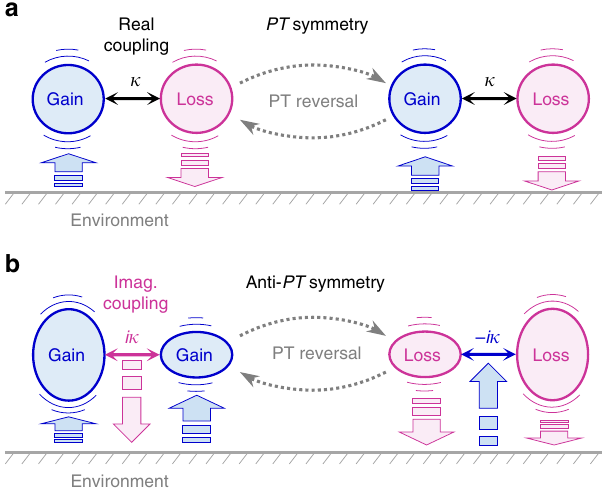
Fig. 1 Schematic diagrams of parity-time and anti-PT symmetric binary systems. a Parity-time (PT)-symmetric coupled oscillators implied by the PT-symmetric Hamiltonian H (PT) in Eq. (1). b Anti-PT (APT)-symmetric binary system derived from the relation H (APT) = ± iH (PT) . In the two diagrams, κ denotes inter-resonator coupling constant and vertical arrows indicate directions of energy exchange between the coupled-resonator system and